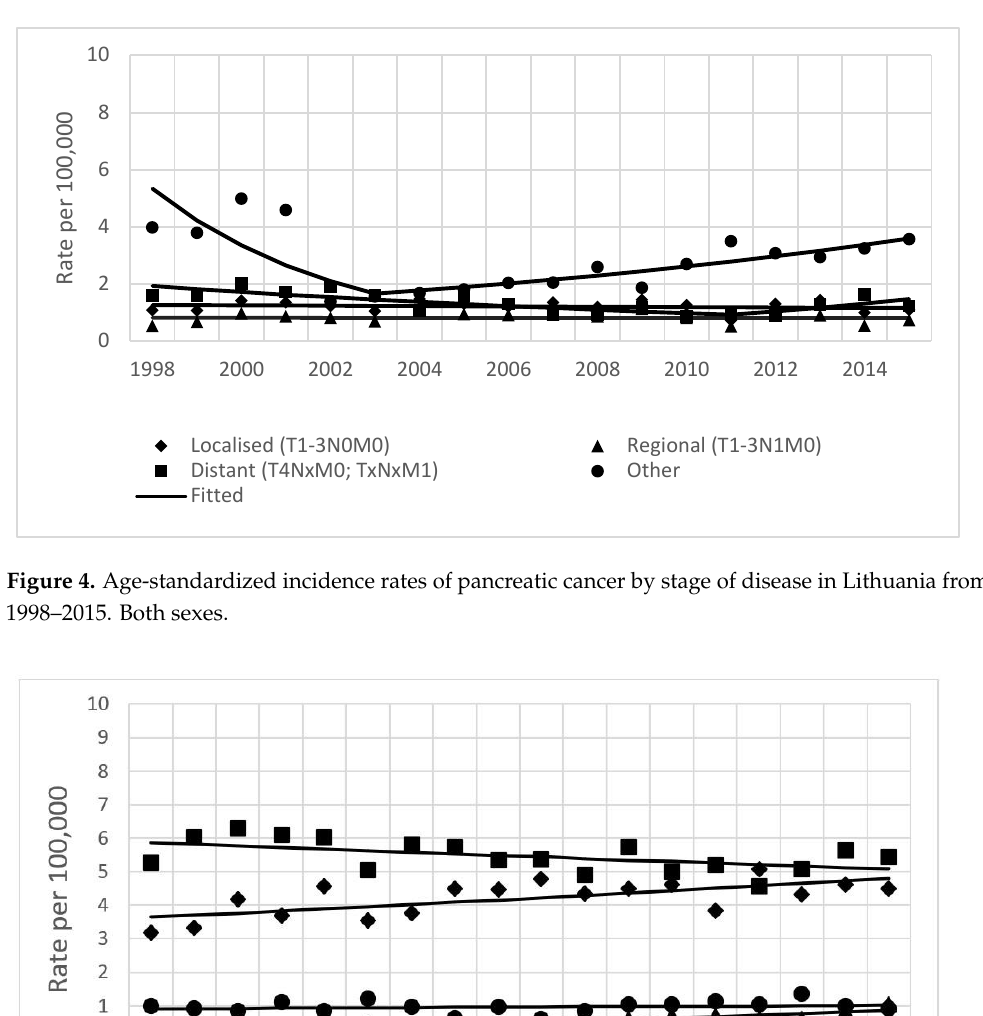
Figure 3. Age-standardized incidence rates of pancreatic cancer by age group in Lithuania from 1998–2015. Both sexes.